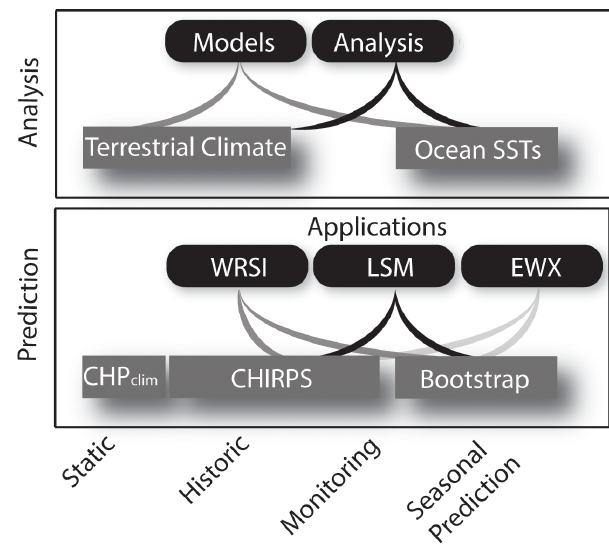
Figure 13. Schema of CHG analysis and prediction